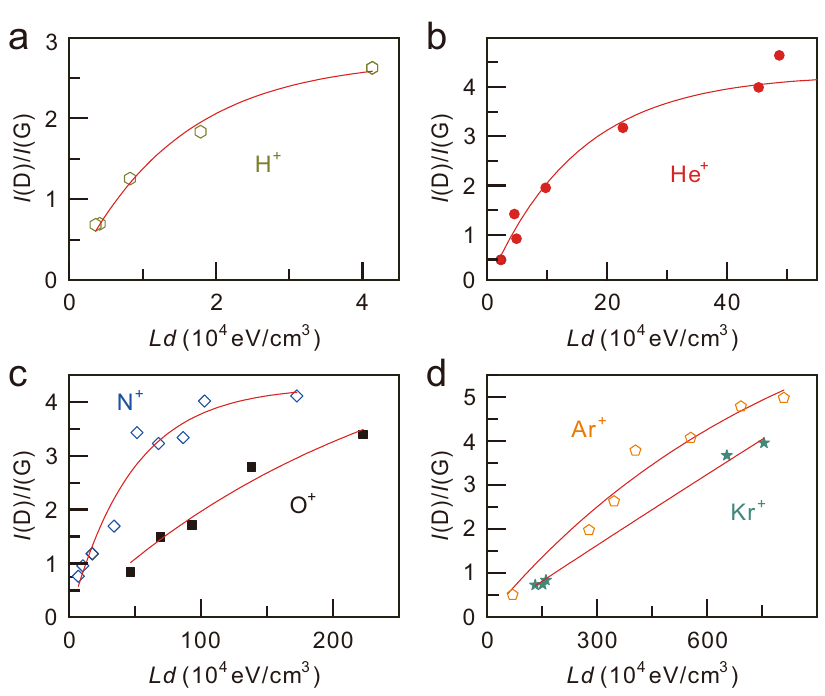
Figure 3. I (D)/ I (G) as a function of L·d for various ion species: H + ( a ), He + ( b ), N + , and O + ( c ) and Ar + and Kr + ( d ). The red lines are the